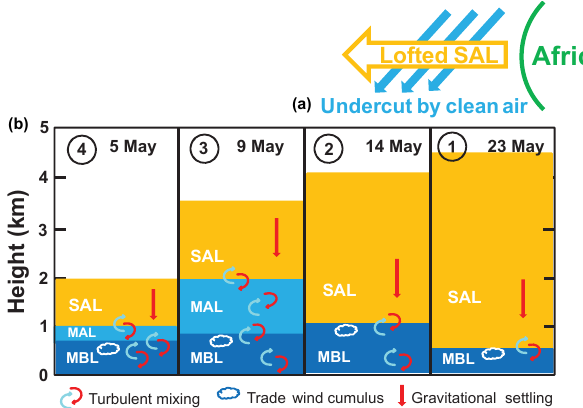
Figure 3. (a) Sketch of the east-to-west dust transport in the lofted SAL which is undercut by clean trade winds from the northeast (oc- curring in the MAL) according to the dust plume conceptual model of Karyampudi et al. (1999), described in Sect. 1.1. (b) Sketch of dust layering (SAL in orange, MAL in blue, the convective part of the MAL, i.e., the MBL, in dark blue). Base and top heights of the MBL, MAL, and SAL are taken from Fig. 2. Gravitational set- tling (symbolized by a red arrow) is responsible for the removal of dust from the SAL; turbulent downward mixing (symbolized by curved arrows) plays an important role in the removal of dust from the MAL according to the